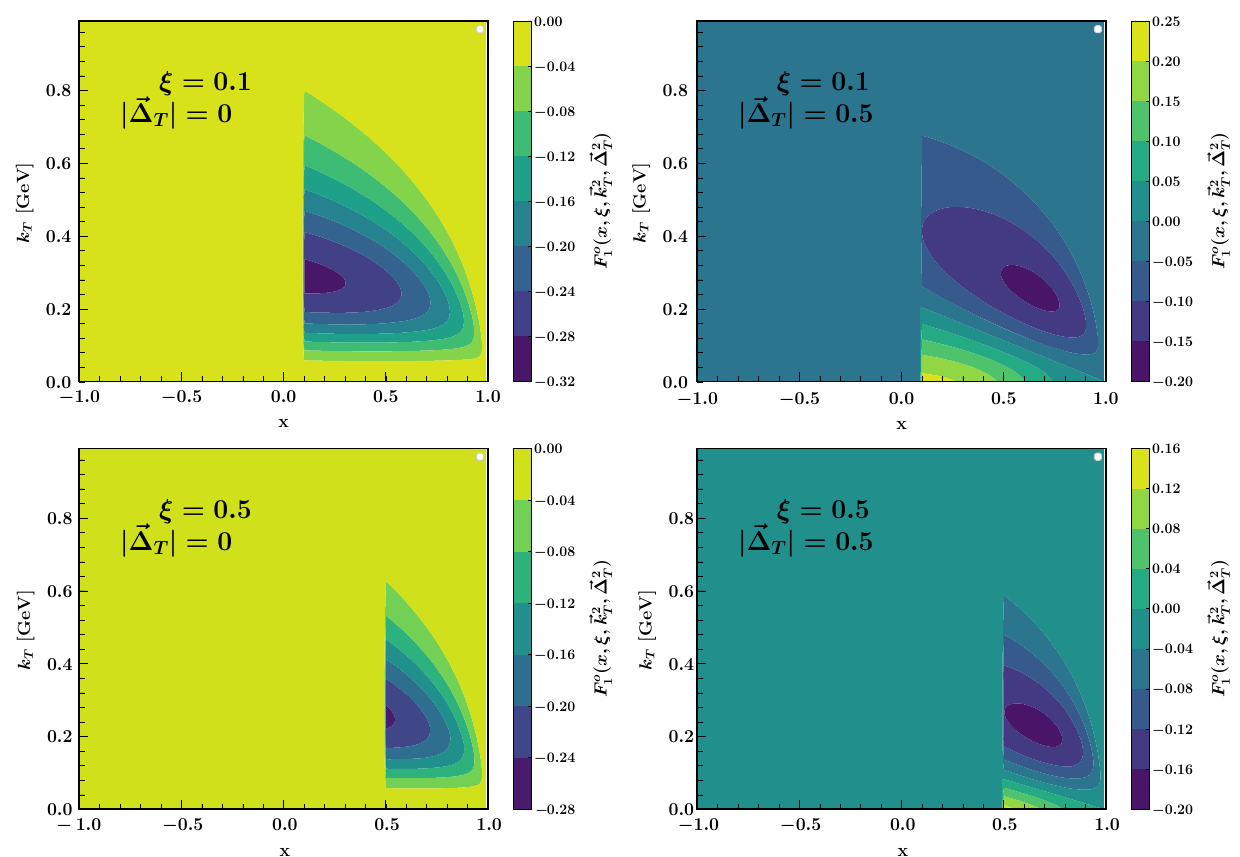
( x ,ξ, (cid:2) k 2 , (cid:2) (cid:3) 2 ) as functions of x and |(cid:2) k T T 1